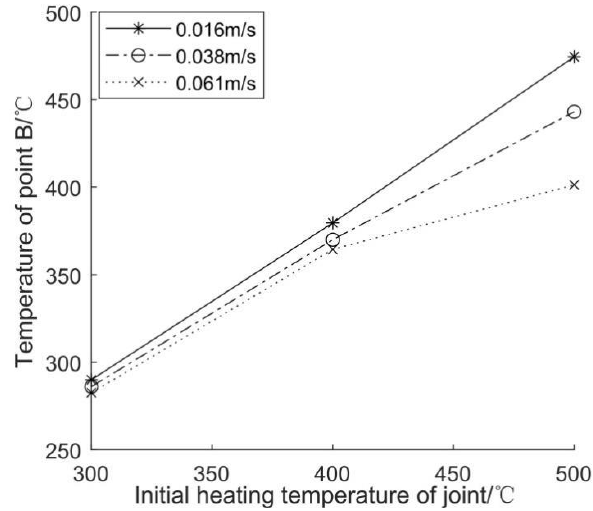
Figure 5. Temperature of point B when the assembly is completed.